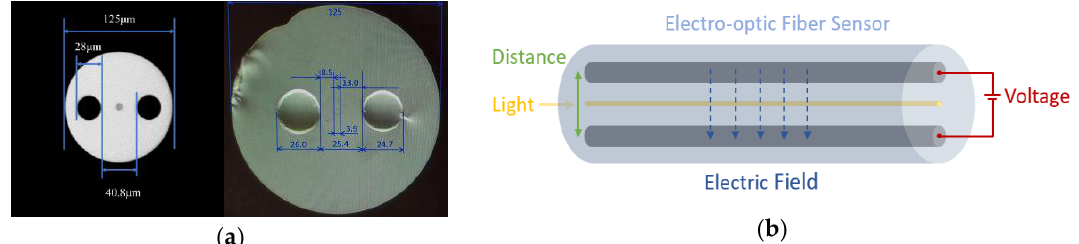
Figure 3. ( a ) Cross-section of the proposed twin-hole silica fiber (left) [38], reprinted with permission from [35] © The Optical Society, and of the thermally poled fiber (right). ( b ) The application of a dc electric field to the electrodes of the electro-optic sensor results in the change of the refractive index in the core of the fiber.